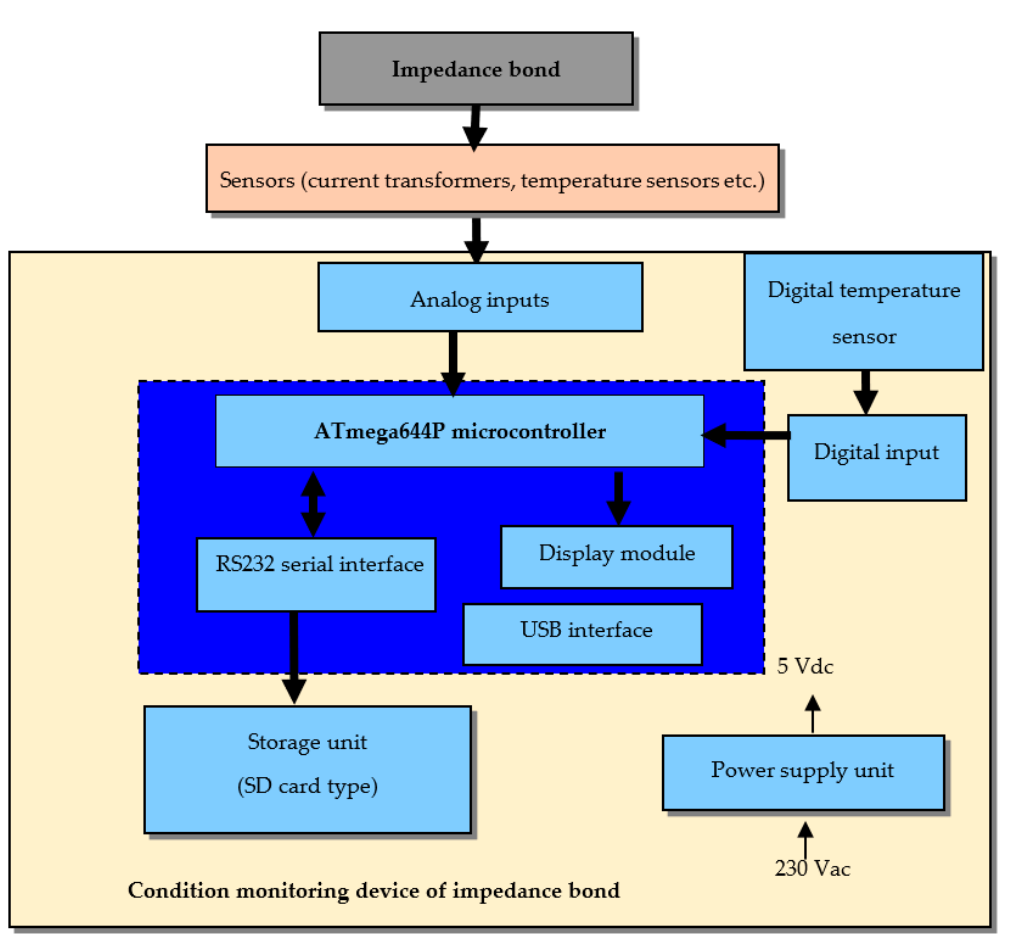
Figure 4. Condition monitoring device block diagram of the impedance bonds.